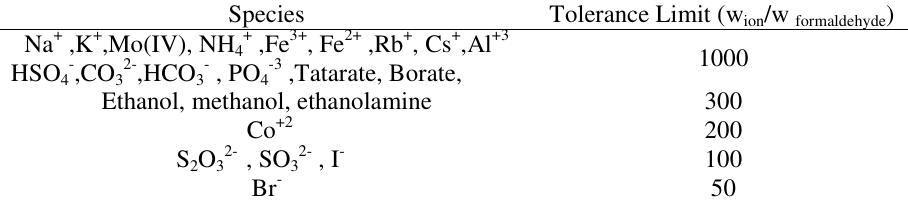
Table 1. Effect of foreign ions on the determination of 0.6µg/ml formaldehyde